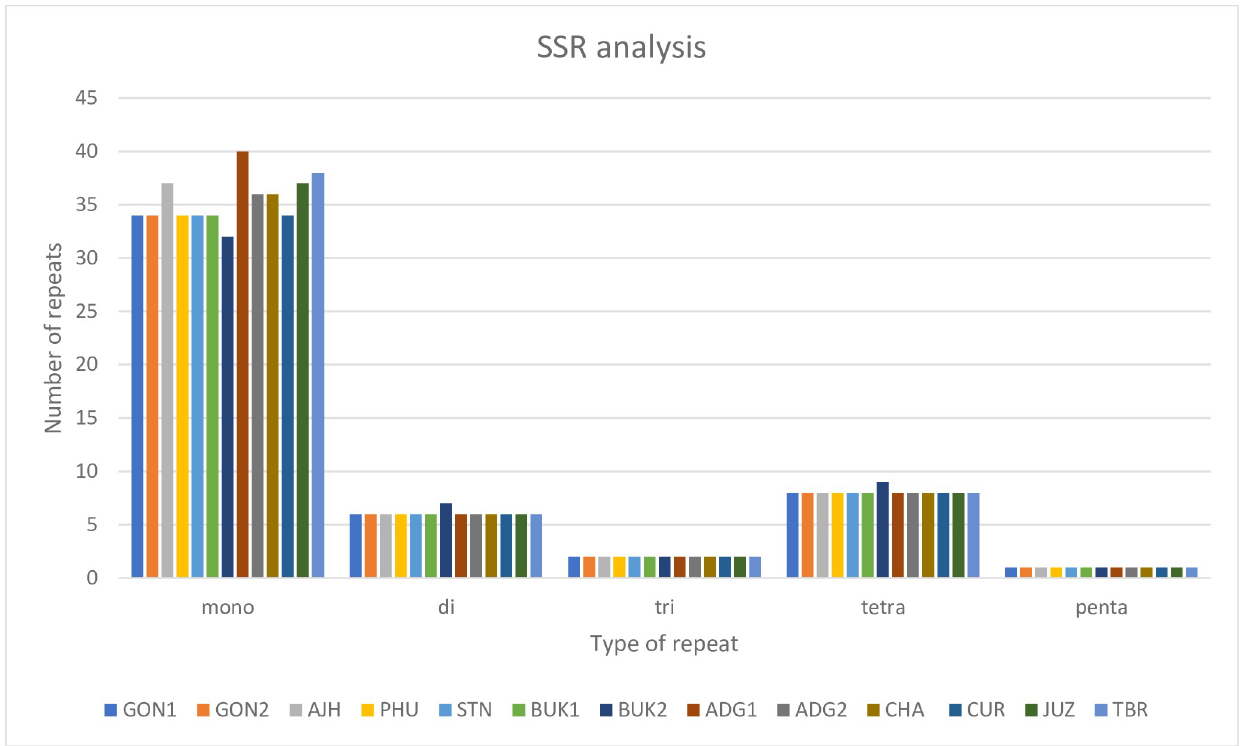
Fig 5. Analysis of SSRs in a panel of 13 potato plastomes. Five SSRs were identified in all the plastomes, namely mononucleotide, dinucleotide, trinucleotide, tetranucleotide, and pentanucleotide repeats. Mononucleotide repeats are the most abundant.